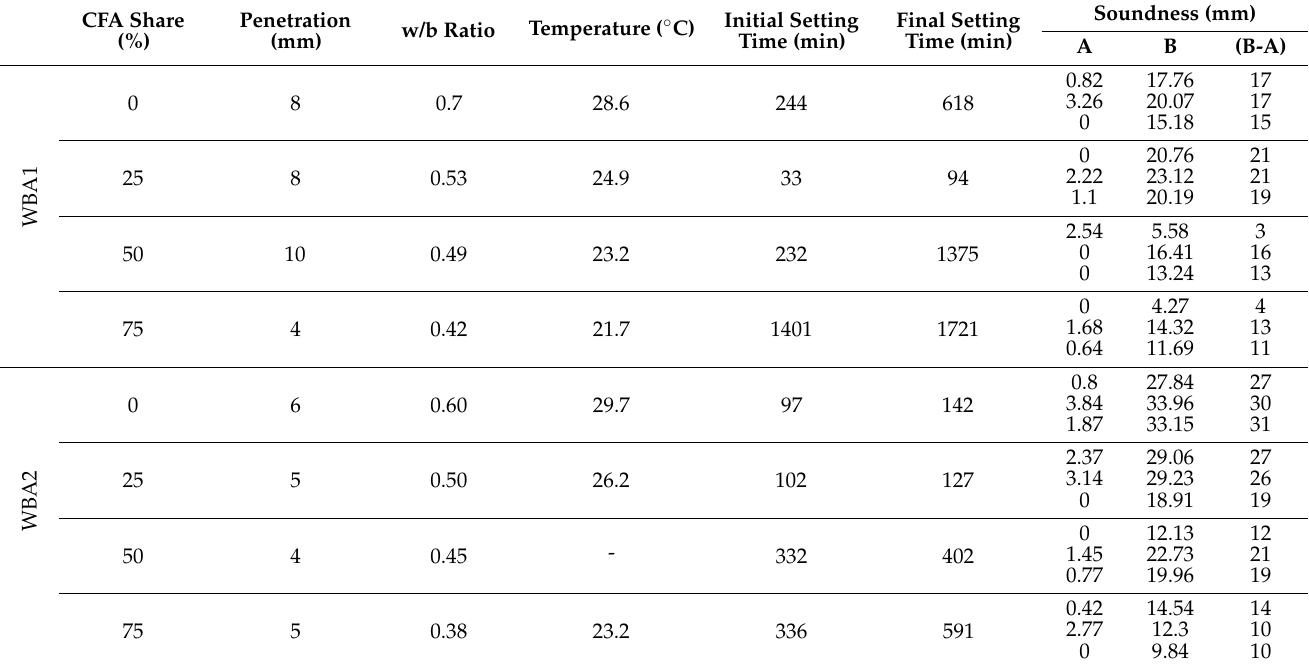
Table 6. Standard consistency, setting time and soundness of